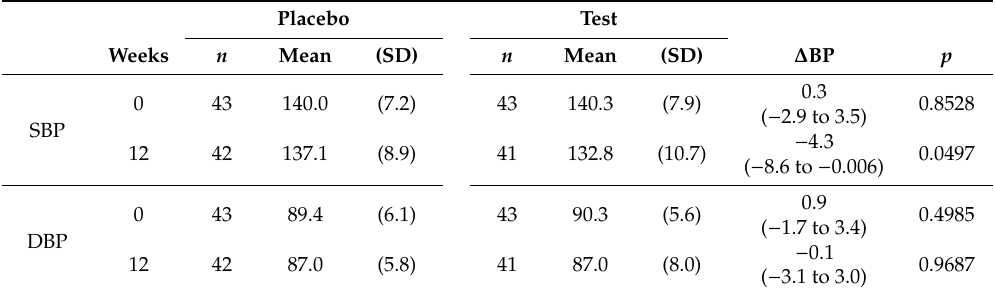
Changes in SBP and DBP in all subjects with high-normal blood pressure and grade 1 hypertension.